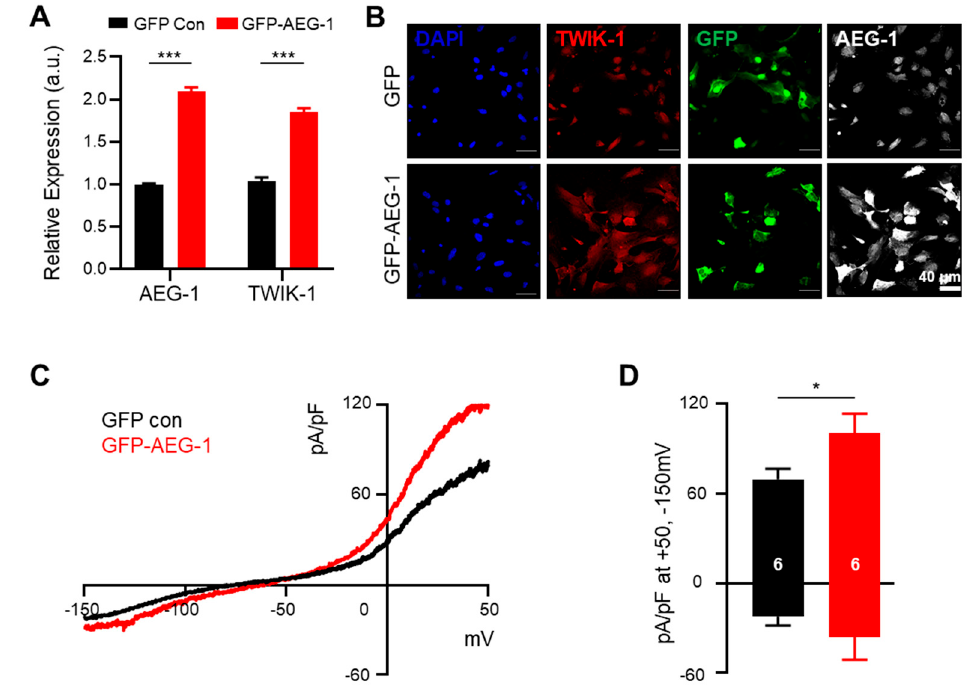
Figure 3. AEG-1 overexpression enhances TWIK-1 mRNA and protein levels and astrocytic potassium currents in cultured astrocytes. ( A ) Overexpression of AEG-1 increases TWIK-1 mRNAs ( B ) Immunofluorescence staining of TWIK-1 and AEG-1 in transfected astrocytes. AEG-1 overexpression increases expression levels of TWIK-1. Scale bar, 40 µ m. ( C ) Representative traces from transfected astrocytes with GFP (control)- and GFP-AEG-1. ( D ) Bar graph showing potassium currents averaged from results in ( C ) at +50 mV and − 150 mV. The number on each bar indicates n for each condition. All values are presented as mean ± SEM. * p < 0.05, *** p < 0.001. P-values were obtained from the Student’s t-test.